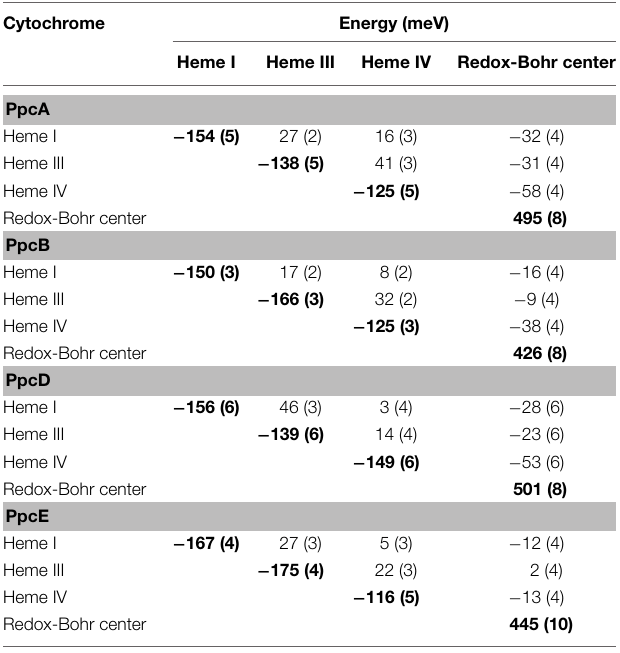
TABLE 1 | Thermodynamic parameters for PpcA, PpcB, PpcD, and PpcE (Morgado et al.,